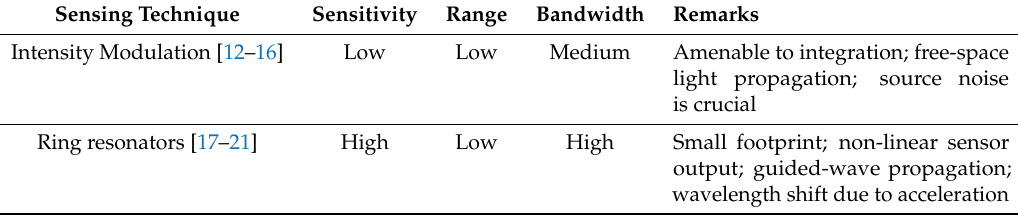
Table 1. Commonly used optical sensing techniques for